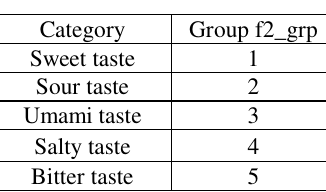
Table 4: Category of taste based on training